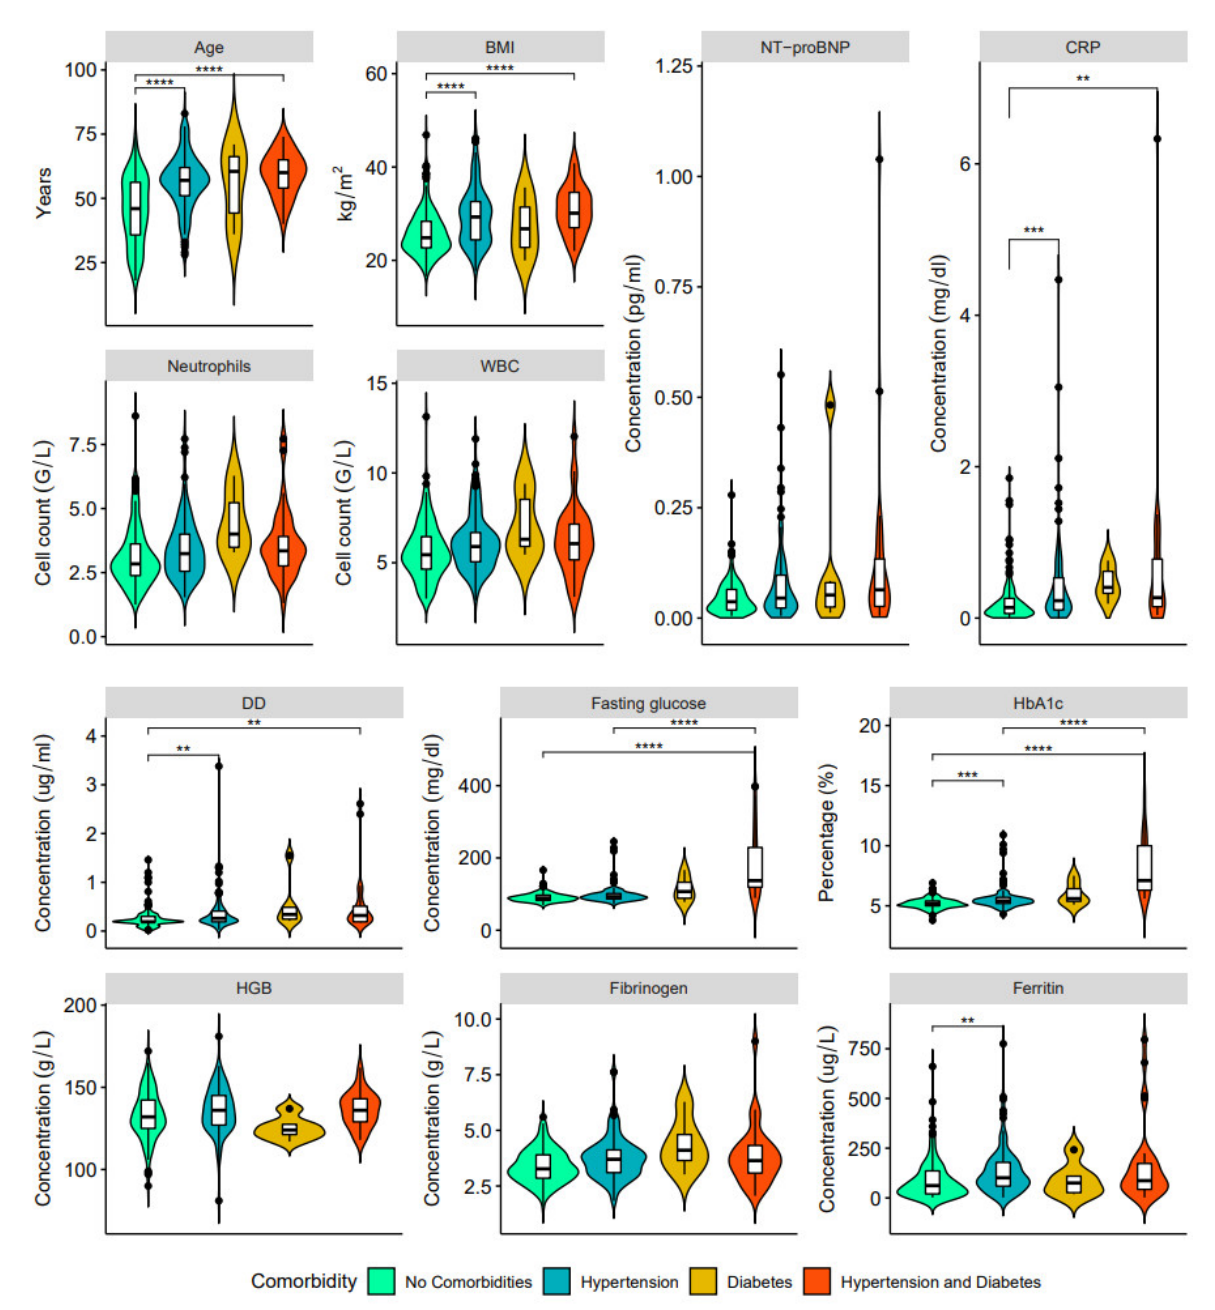
Figure 4. Clinical characteristics and laboratory results of blood samples in post-COVD-19 patients with no comorbidities (green), hypertension only (blue), type 2 diabetes mellitus only (orange) and both hypertension and type 2 diabetes (red): age, BMI, NT-proBNP, CRP, neutrophils, WBC, DD, fasting glucose, HbA1c, HGB, fibrinogen, and ferritin (** p < 0.01, *** p < 0.001, **** p < 0.0001).